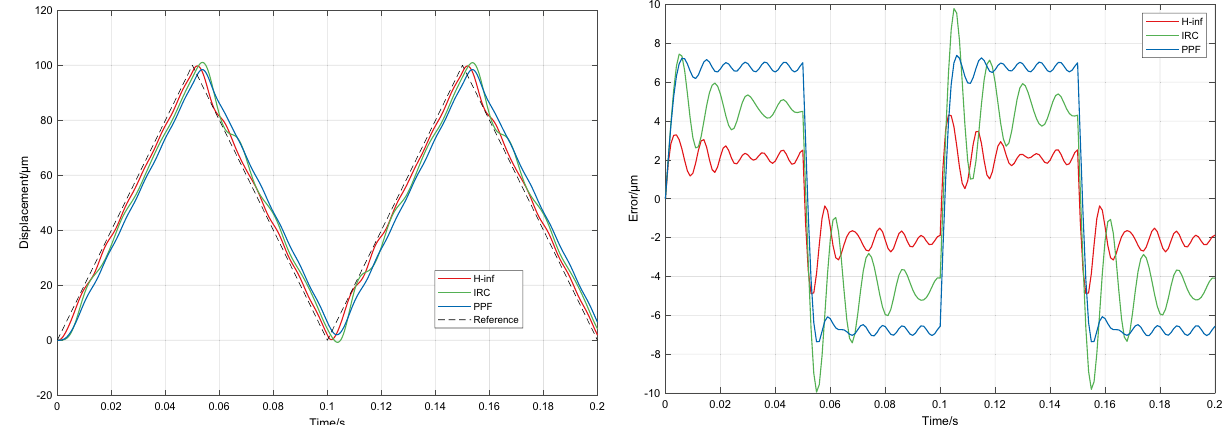
Figure 11. The system tracks a 10 Hz raster scan signal at a mechanical load of 1000 g and a perturbation frequency of 139